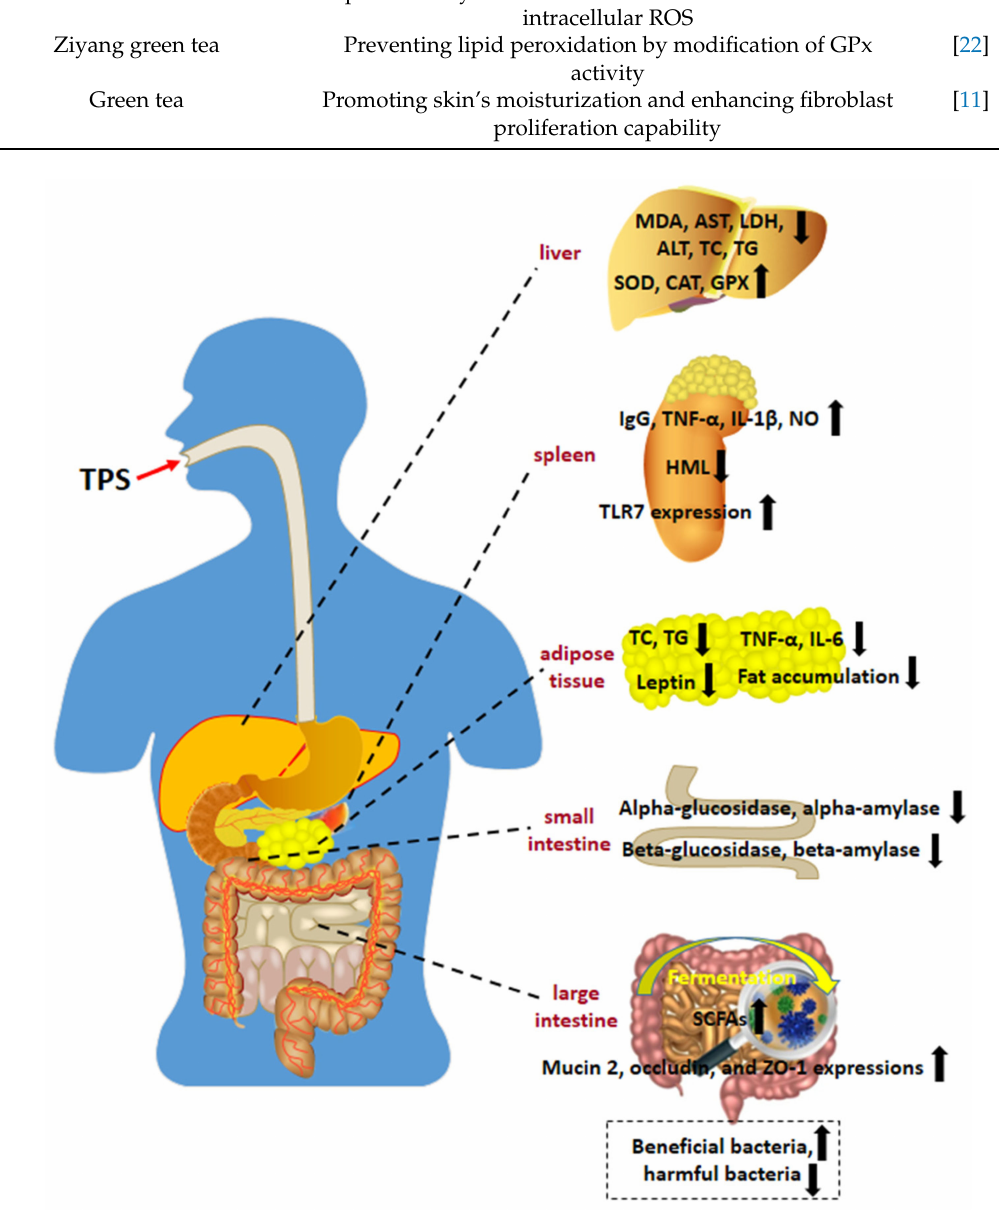
Figure 3. A potential mechanism by which TPS exerts its in vivo